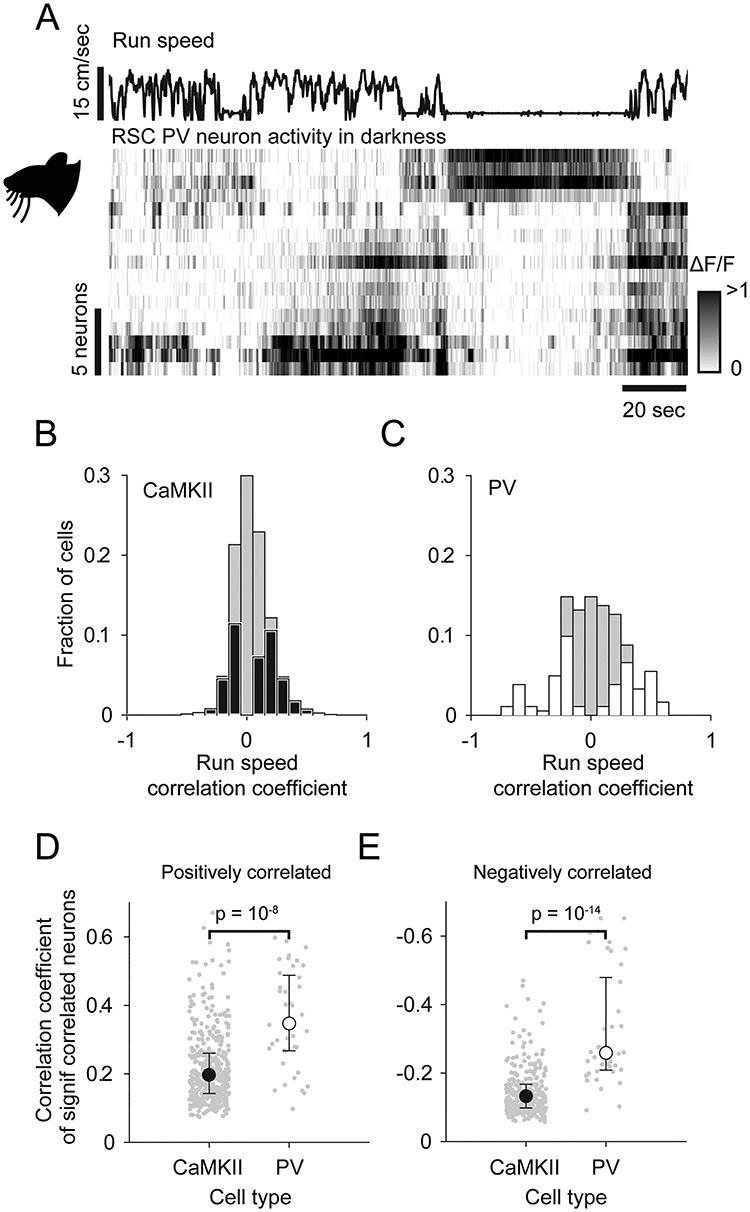
Activity of PV RSC neurons in darkness. (A) Run speed, and below, raster representation of neural activity (rows are individual neurons) sorted by run speed correlation. (B,C) Histogram of run speed correlations of CaMKII neurons (B, black) and PV neurons (C, white) with the nonsignificantly correlated fraction of neurons represented by gray bars. (D,E) Median fraction of neurons which is significantly positively locomotion correlated (D) or negatively locomotion correlated (E). Error bars indicate interquartile range.